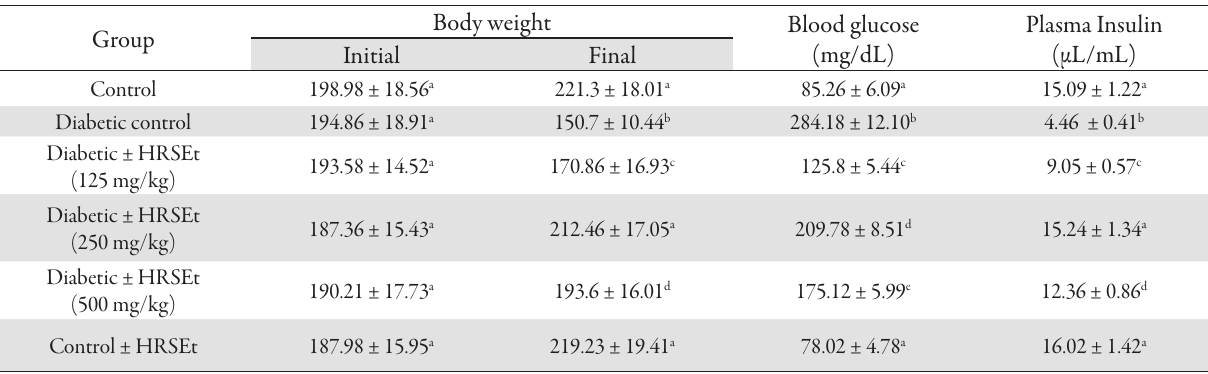
Tab. 1. Effect of HRSEt on body weight, blood glucose and plasma insulin levels of control and experimental rats Group